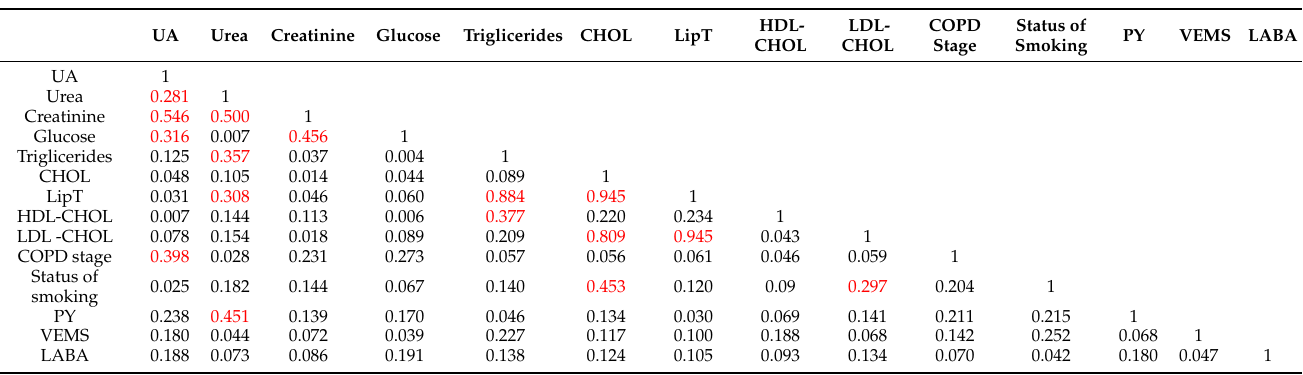
Table 3. Application of the Spearman correlation to biochemical parameters and long-acting beta 2-agonists in case of patients with COPD.